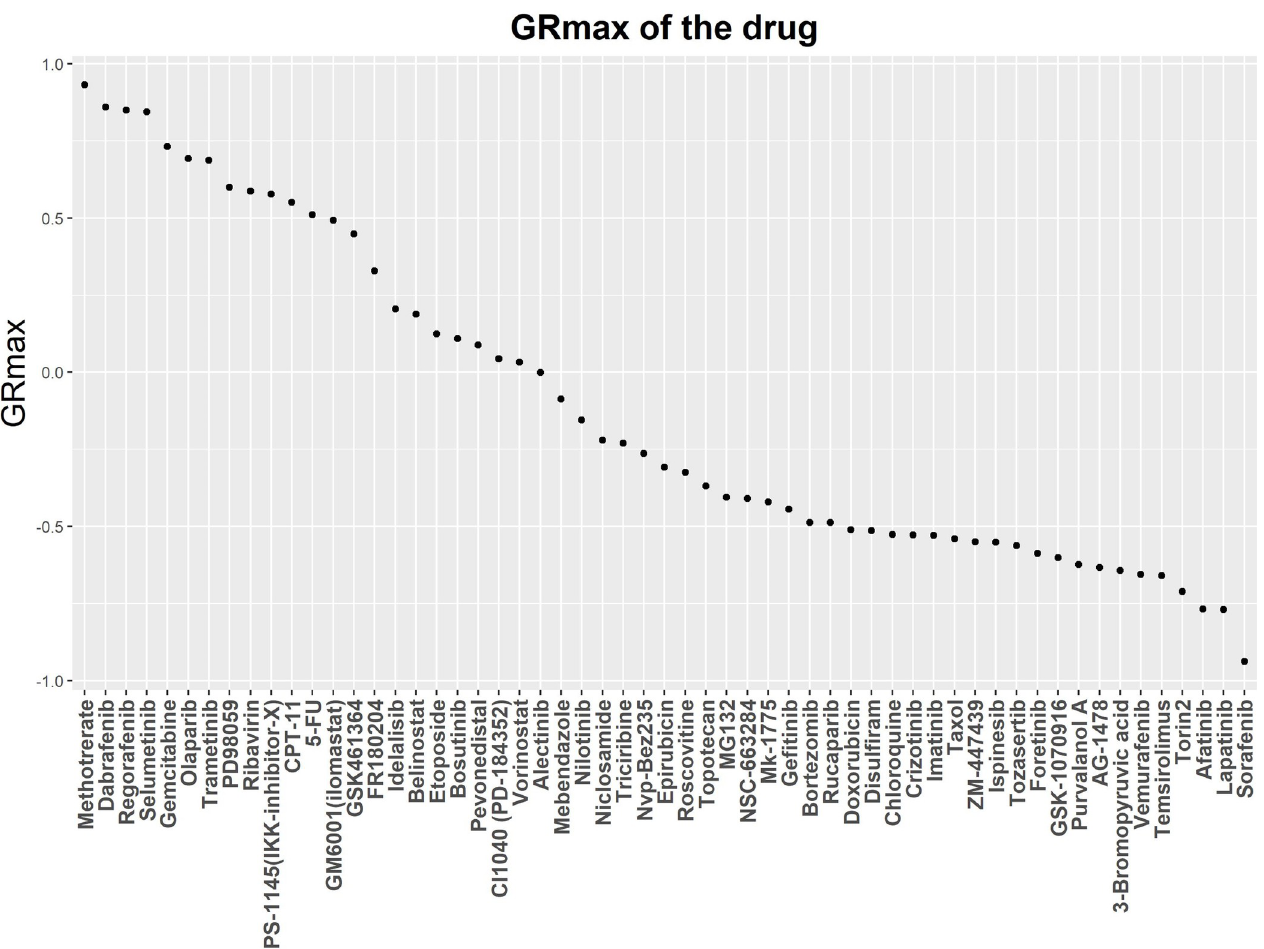
Fig 4. GRmax distribution of the 57 drugs sorted by GRmax